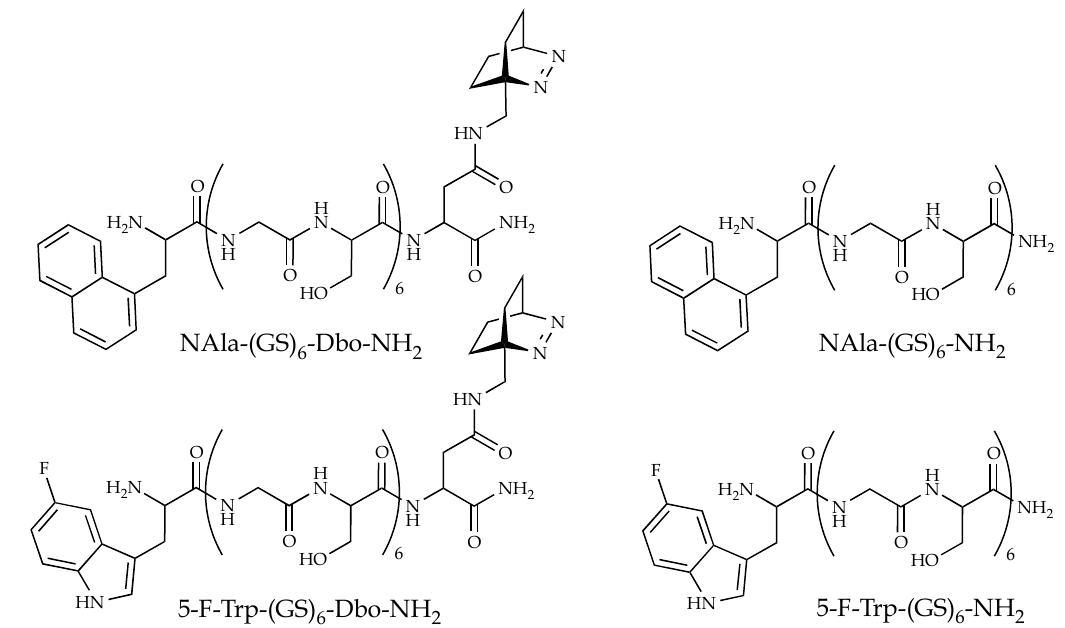
Figure 1. The selected donor-acceptor and donor-only labeled peptides composed of Gly-Ser units. Donors are N-terminal naphthyl-1- L -alanine (NAla) and 5-fluoro- L -tryptophan (5-F-Trp); the acceptor is C-terminal Dbo, whose optically active group is the azo group of the bicyclic